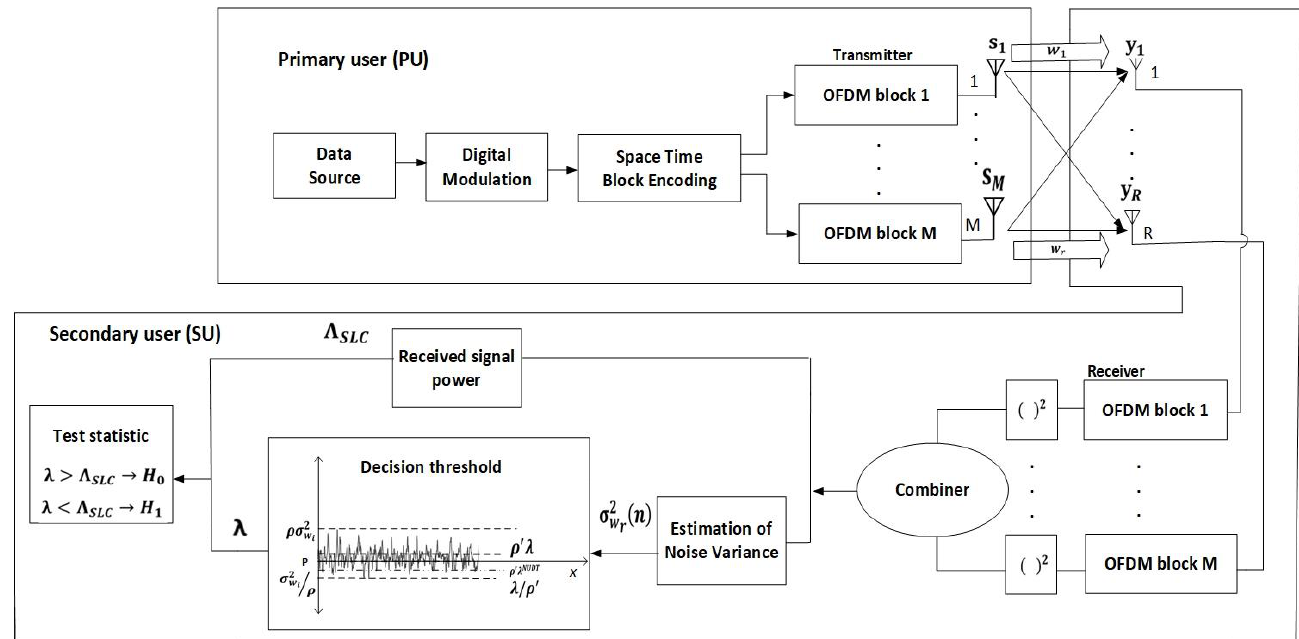
Figure 1. Main blocks of the MIMO-OFDM wireless communication system for SS based on ED employing SLC technique.